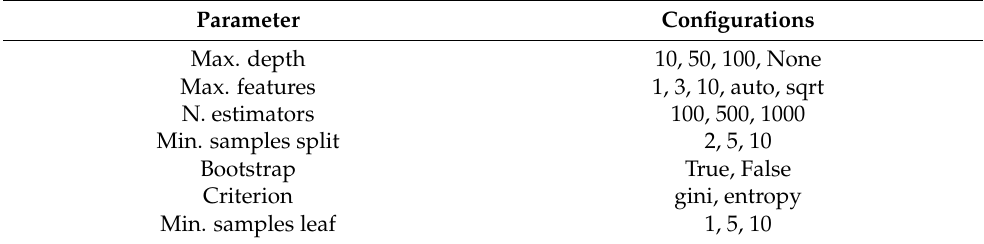
Table 12. RF parameters and their configuration used for the grid search to determine the best configuration for substrate specificity prediction. Each parameter is described in detail in the scikit-learn documentation [48].